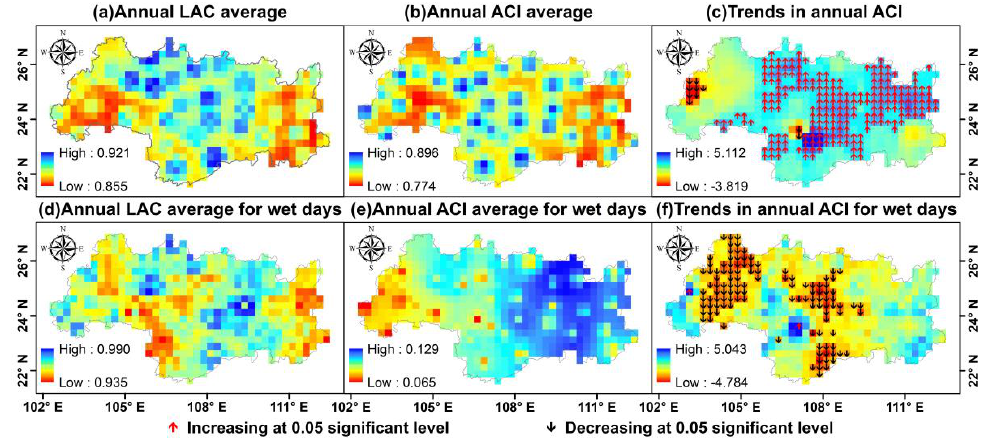
Figure 5. The average values and trends of ACI and LAC for annual all days and wet days in 1960 – 2008.